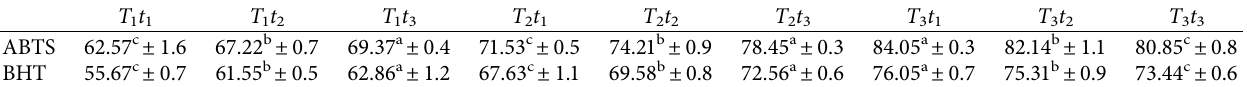
Table 5: Interaction efects of temperature ( T ) and time ( t ) on ABTS